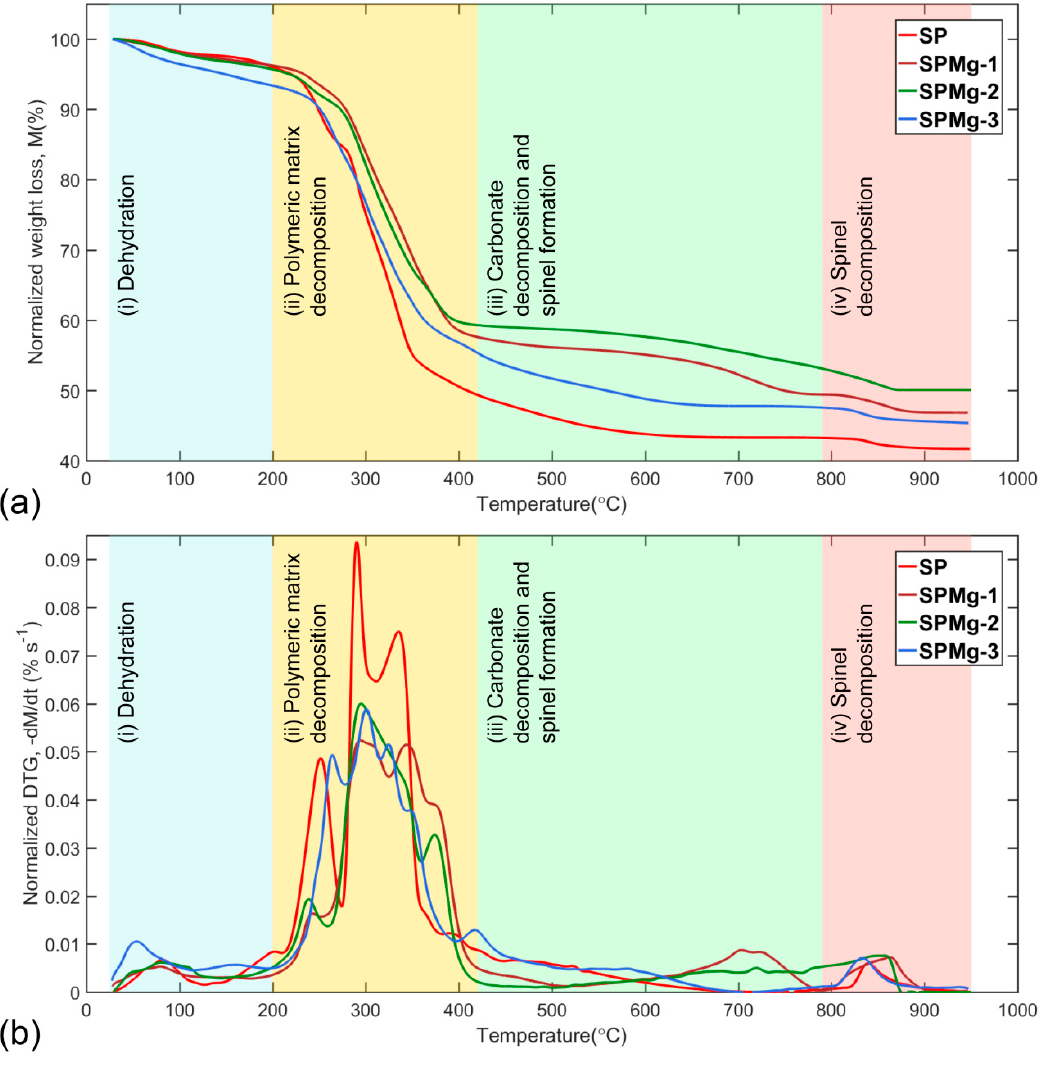
Table 1. Percentages and maximum rates of mass loss of the thermal decomposition zones of the synthesis precursors.